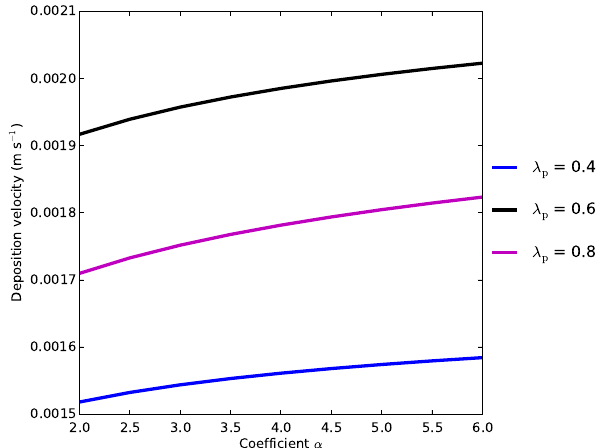
Figure 16. Dry deposition velocity as a function of β and building